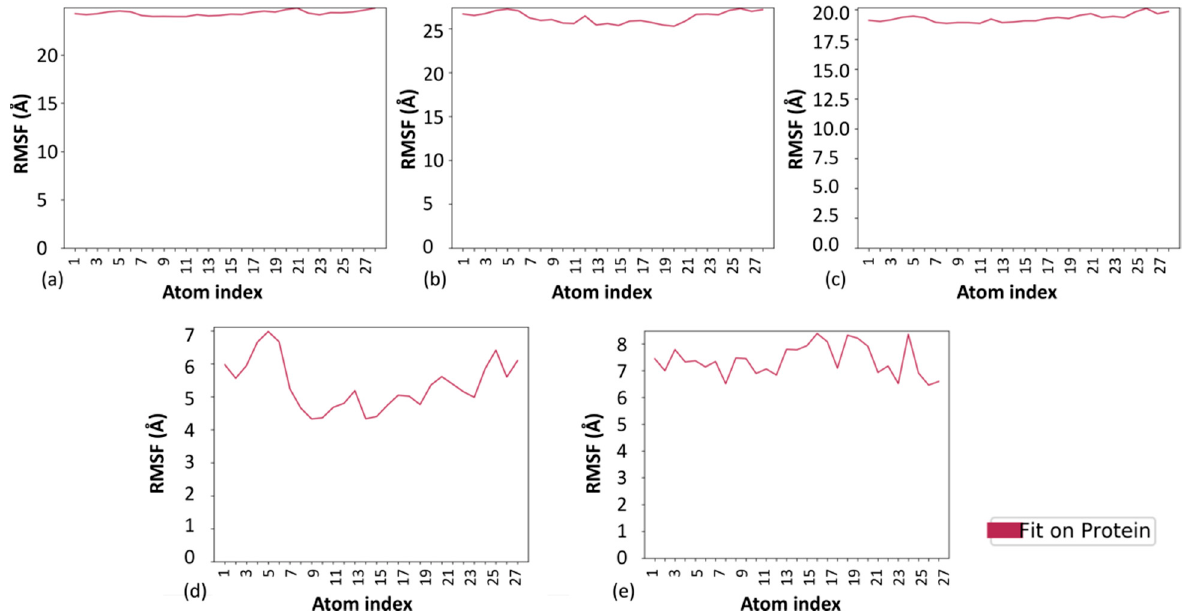
Figure 6. RMSF of modeled compounds during MD simulations with β -lactamase crystal structure ( a ) (3 R ,4 R )- 11f , ( b ) (3 S ,4 S )- 11f , ( c ) (3 S ,4 R )- 11f , ( d ) (3 R ,4 S )- 11f , ( e ) oxacillin.